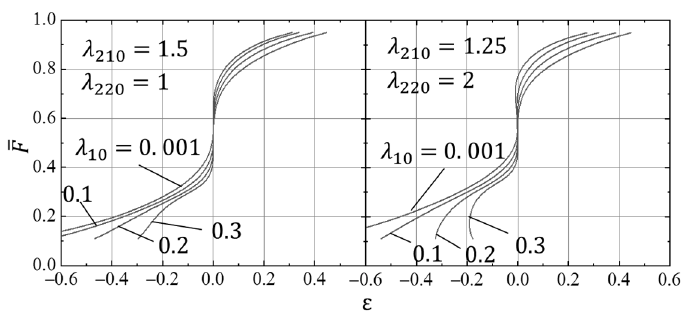
Figure 7. The effect of λ 10 on the static characteristics of the oil pad.